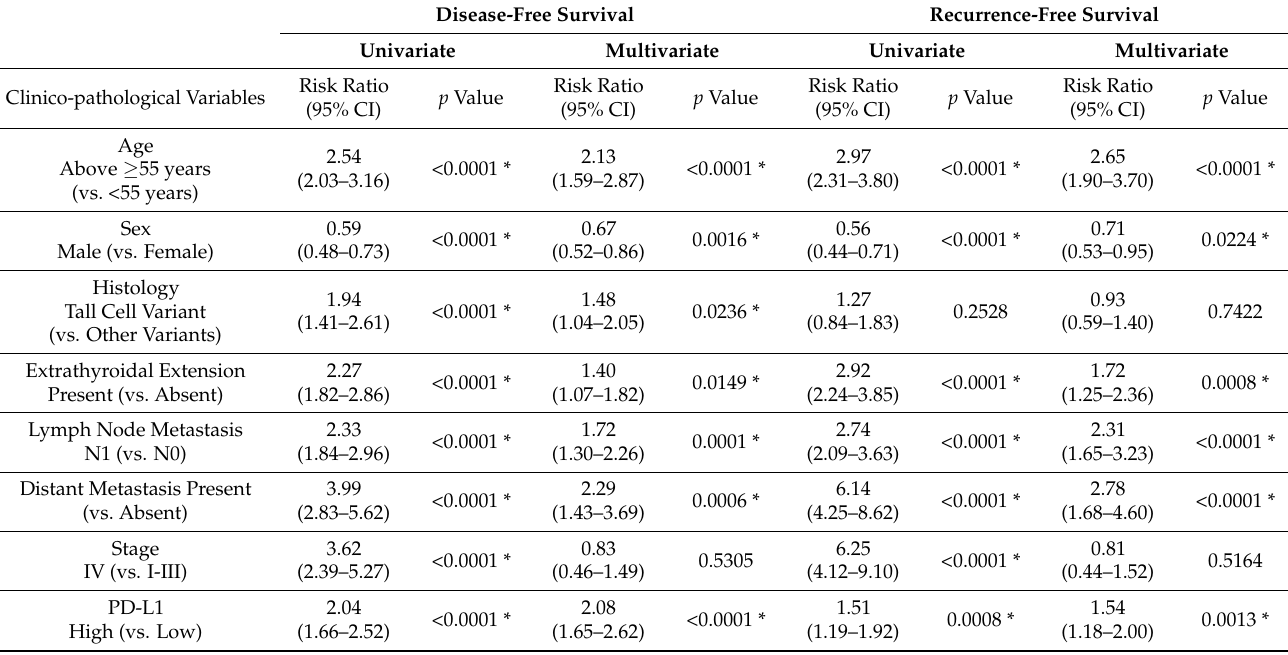
Figure 1. PD-L1 immunohistochemical staining in papillary thyroid carcinoma (PTC) tissue microarray (TMA). Representative examples of tumors showing ( A ) high expression and ( B ) low expression (right panel) of PD-L1. A 20 ×/0.70 objective on an Olympus BX 51 microscope (Olympus America Inc., Center Valley, PA, USA) with the inset showing a 40 × 0.85 aperture magnified view of the same TMA spot. Table 2. Cox regression model analysis for prediction of disease-free survival and recurrence-free survival.